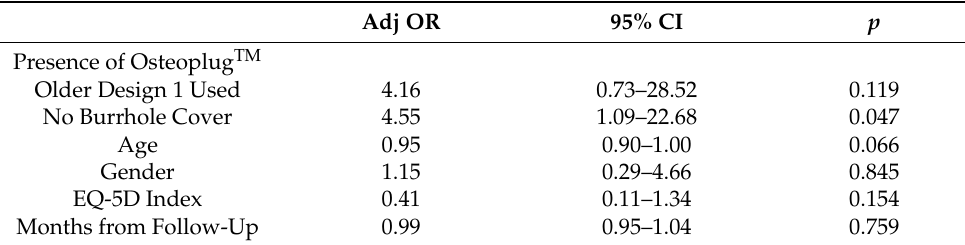
Table 4. Multivariate logistic regression for low Aesthetic Numeric Analog score.